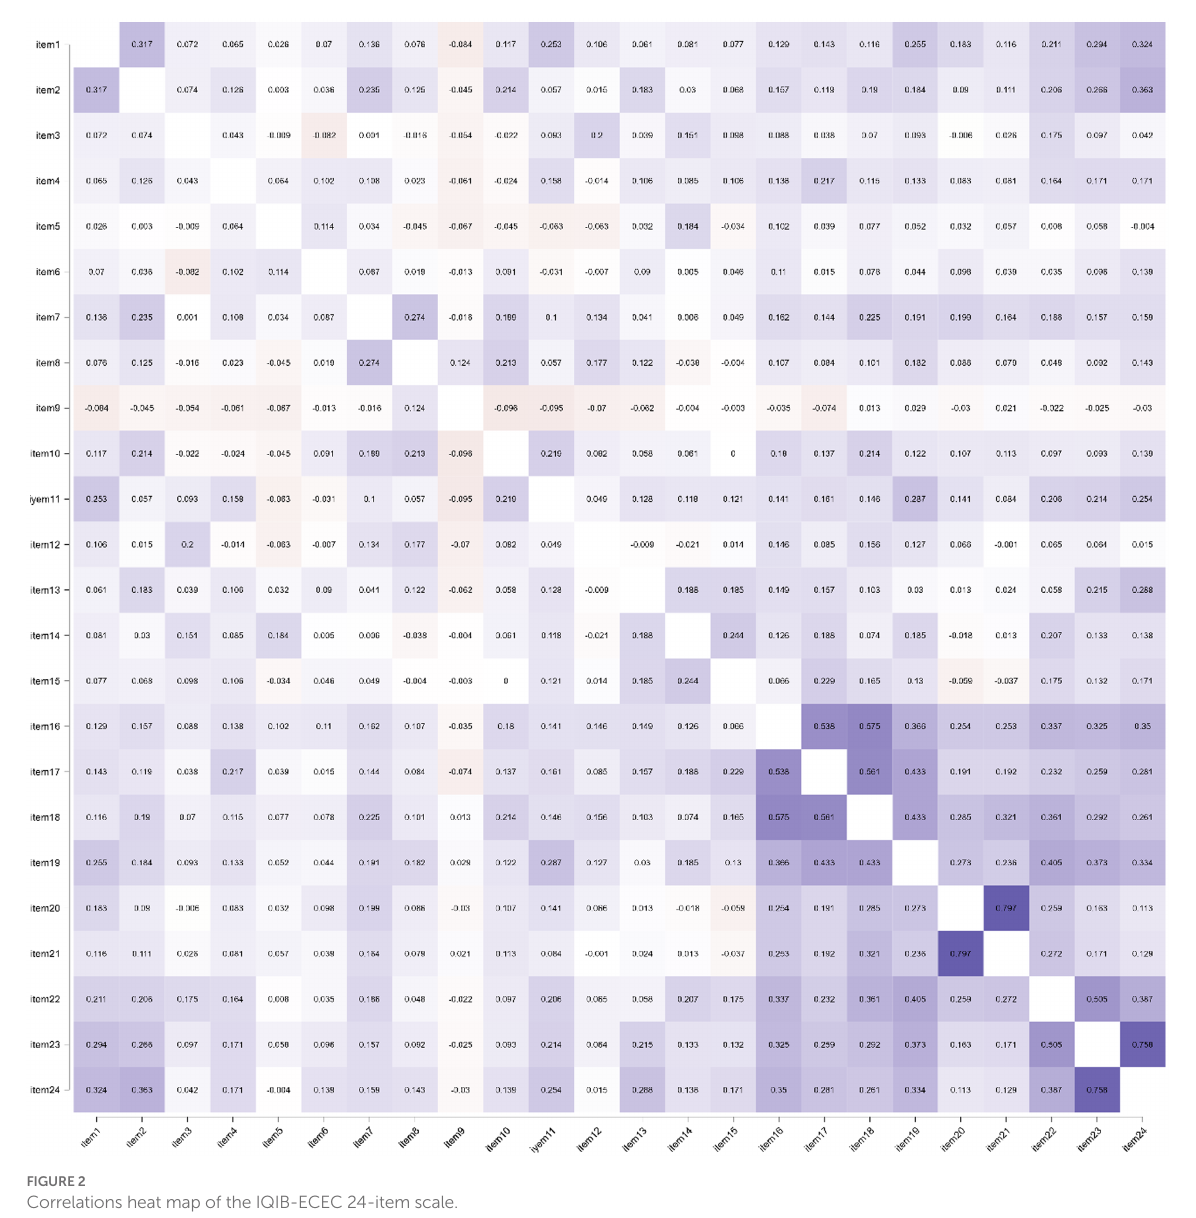
FIGURE 2 Correlations heat map of the IQIB-ECEC 24-item